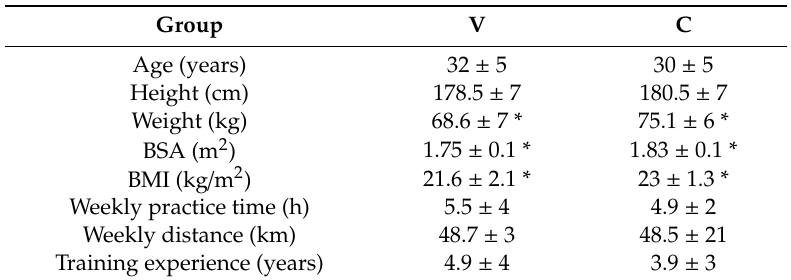
Table 1. General